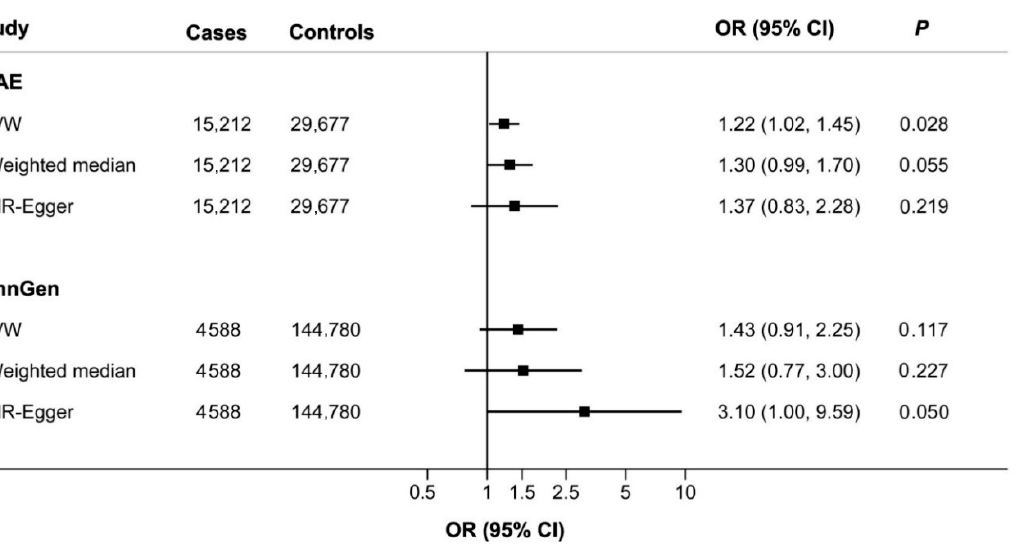
Figure 2. ( A ) Associations of genetically predicted alcohol and coffee intake with epilepsy in ILAE, in FinnGen, and combined analyses of both samples. ( B ) Association of genetically predicted milk intake with epilepsy in FinnGen. Genetically predicted coffee consumption was not related to epilepsy risk (OR: 0.96; 95% CI: 0.74–1.23; p = 0.736 in ILAE consortium; OR: 1.00; 95% CI: 0.66–1.51; p = 0.996 in FinnGen consortium, Figure 2A). Genetically predicted milk intake showed a suggestive association with a lower risk of epilepsy in the FinnGen consortium. The OR was 0.957 (0.917–0.999, p = 0.044, Figure 2B) for each additional milk intake increasing allele (T).